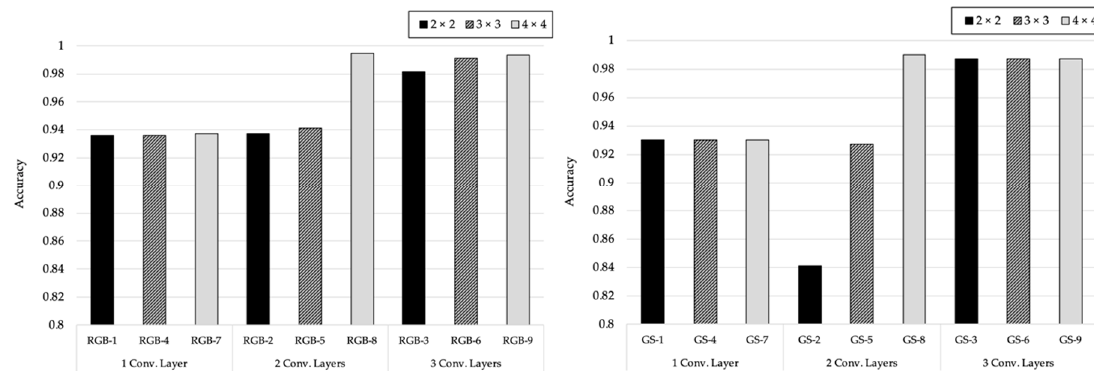
Figure 9. Comparison of Accuracy by size of kernel in case of CSE-CIC-IDS 2018.